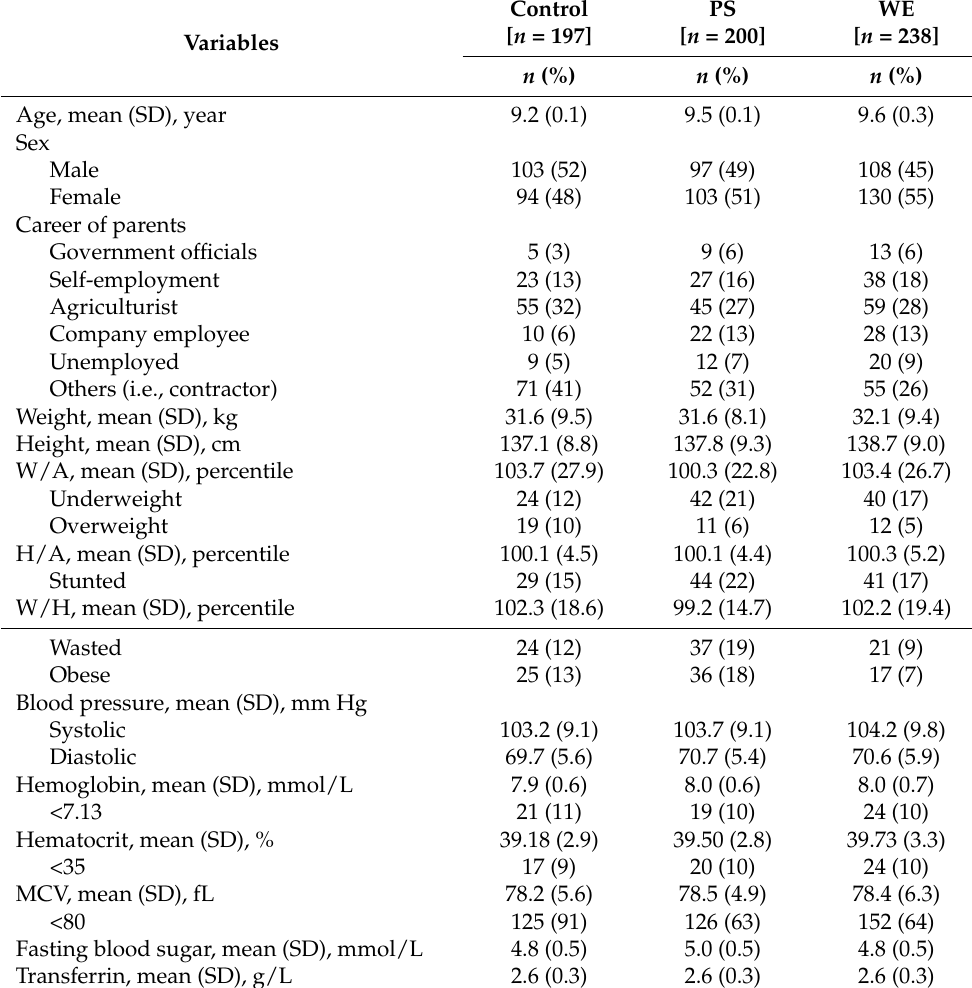
Table 1. Baseline characteristics of